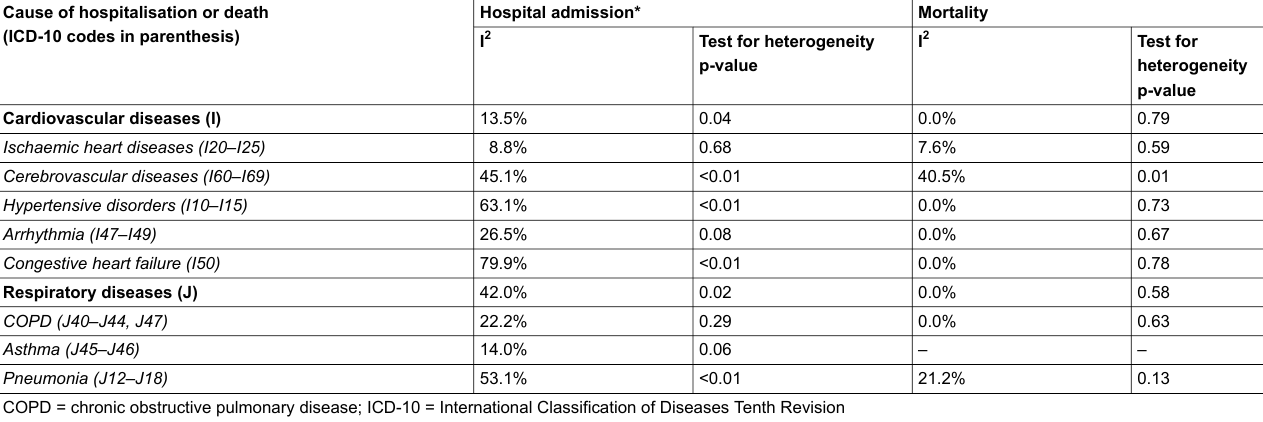
Table S3: Assessment of heterogeneity within canton-specific results included in the